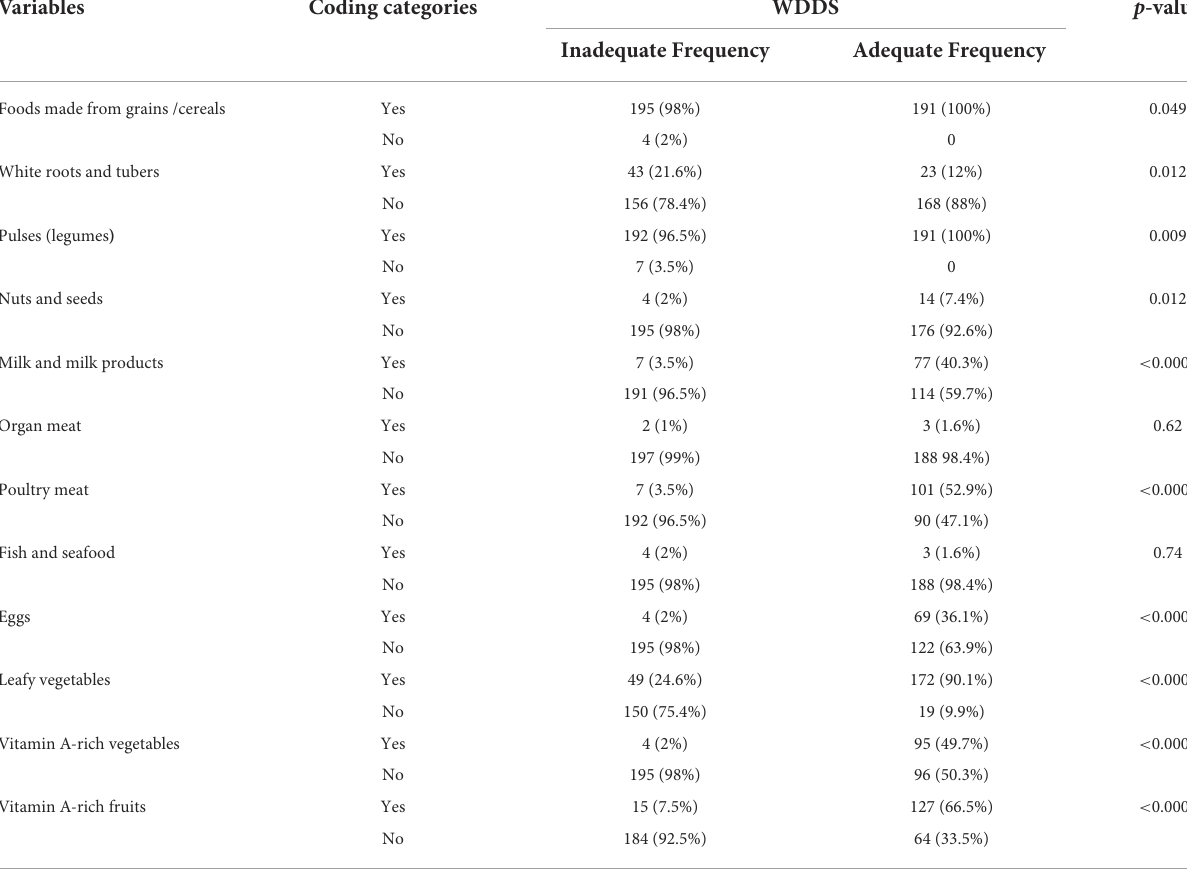
TABLE 2 Food groups consumed by the study participants within 24h of the interview in the east Gojjam zone, northwest Ethiopia, 2019/2020. Variables Coding categories WDDS p -value Inadequate